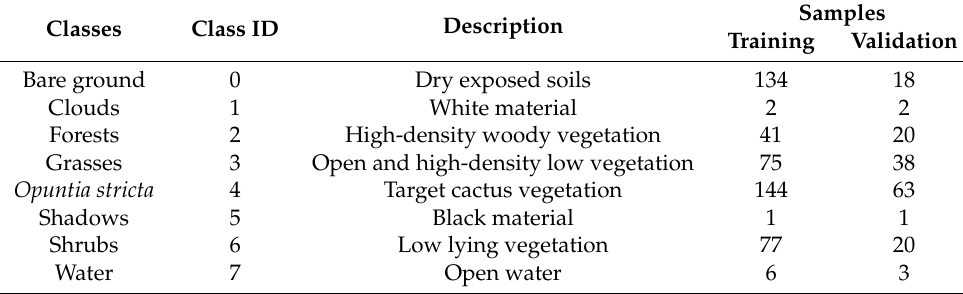
Table 1. Landcover classes and sample pixel number collected for the